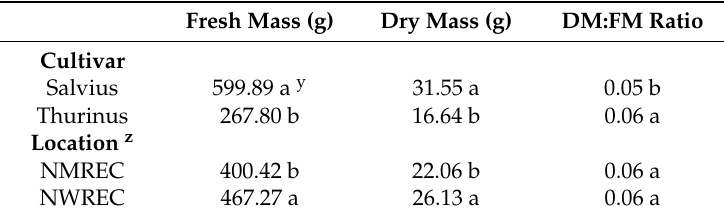
Table 1. Fresh mass (FM, g), dry mass (DM, g), and the ratio of DM to FM as affected by lettuce cultivars and growing